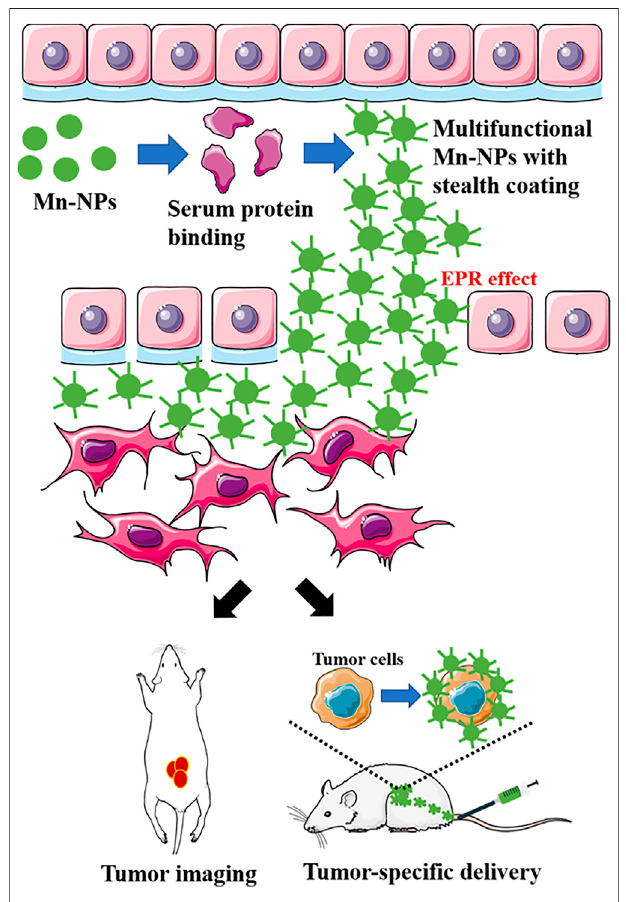
FIGURE 3 | Different approaches of Mn-NPs in cancer diagnosis and treatment.